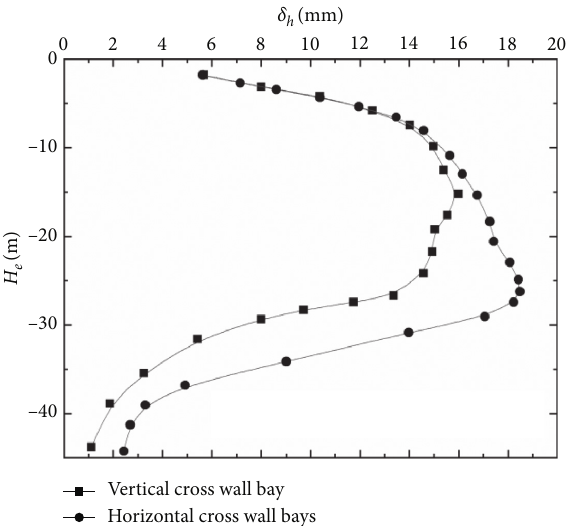
Figure 20: The wall deflection under two different layouts of the cross wall.